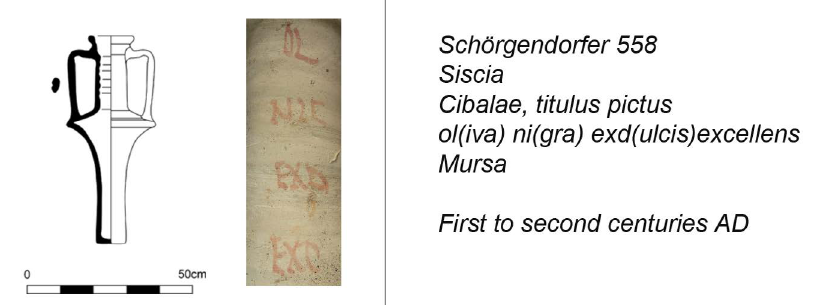
Figure 2: Schörgendorfer 558 amphora with black olive inscription, dated 1 st to 2 nd century